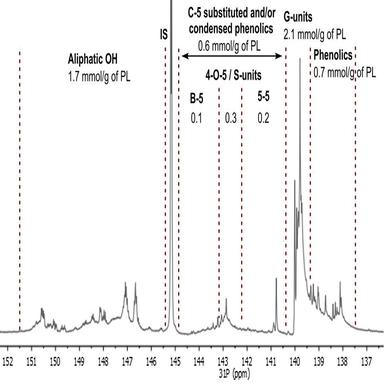
31P NMR spectrum of PL and integration results of assigned regions (solvent: chloroform-d).